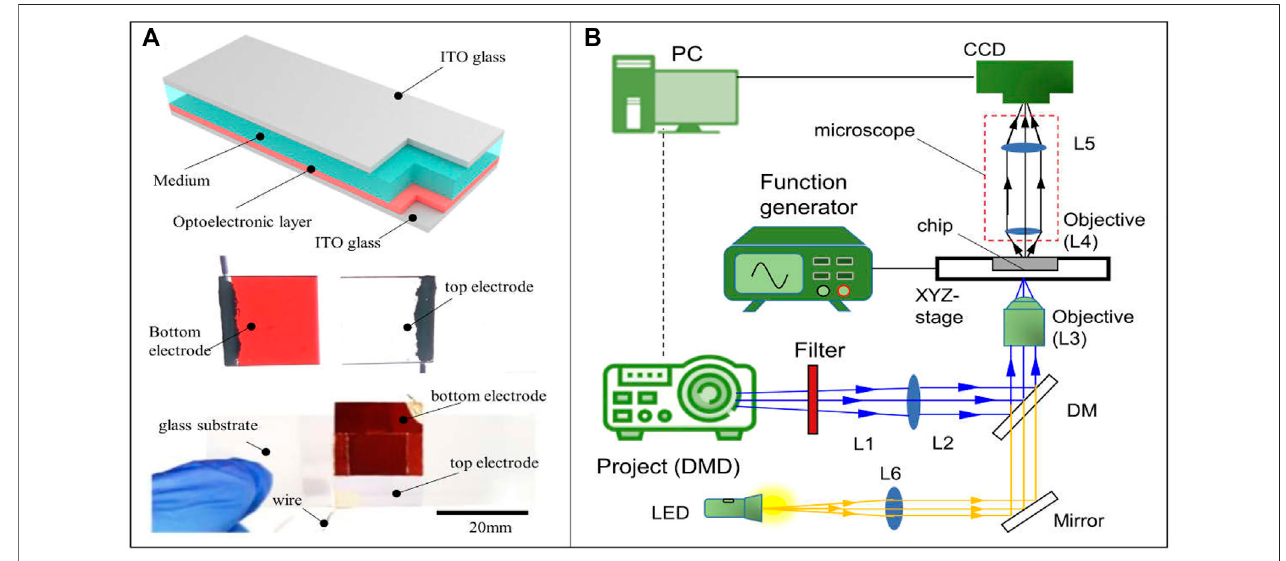
FIGURE 2 | Simple schematic diagram of (A) the chip and (B) the OET.